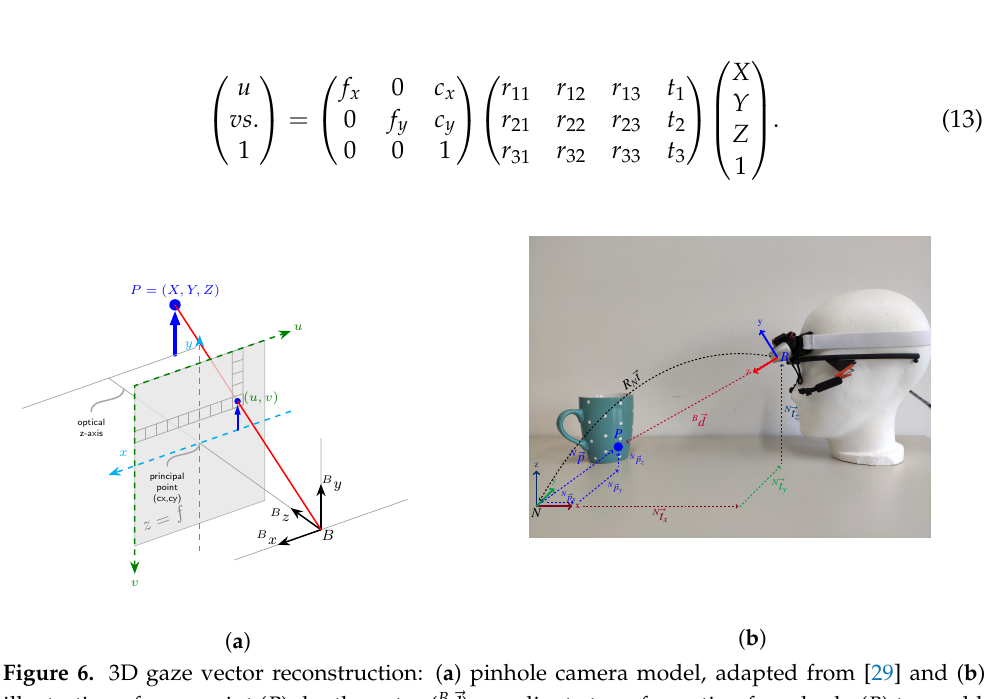
Figure 6. 3D gaze vector reconstruction: ( a ) pinhole camera model, adapted from [29] and ( b ) illustration of gaze point ( P ) depth vector ( B (cid:126) d ) coordinate transformation from body ( B ) to world coordinate frame ( N ), where N is either coincident with the robots origin or the transformation from N to the robots’ origin is known and incorporated into the inverse kinematic chain. The vector N (cid:126) p is the input target point for the inverse kinematic calculation of the robotic